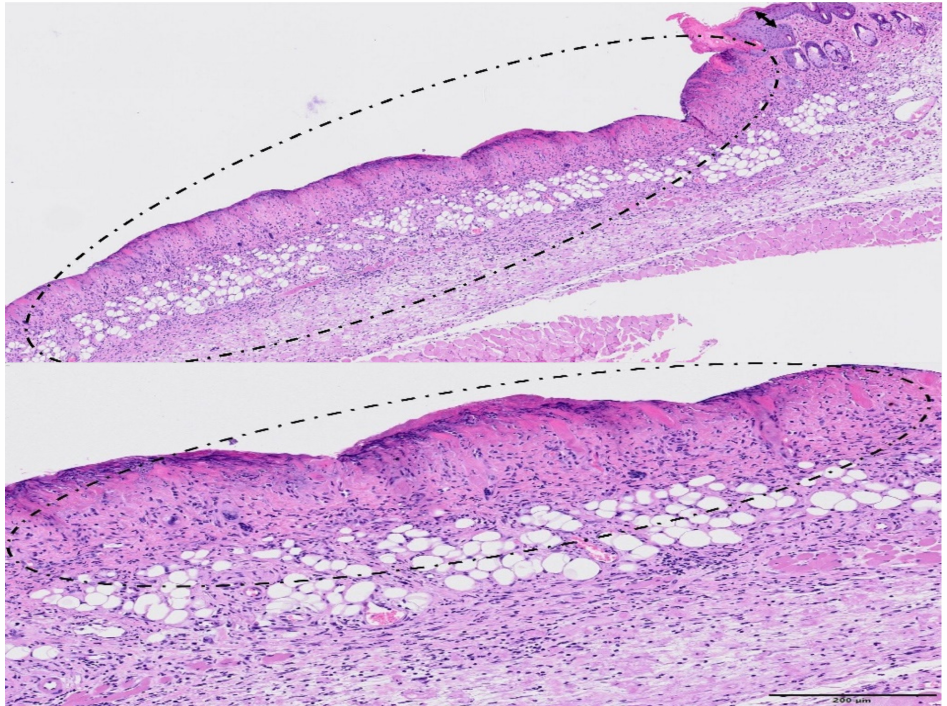
Figure 11. Broad beam irradiation. HE staining. Upper figure (bar = 500 µ m): a large area of the skin presented extensive epidermal necrosis (encircled), with abundant inflammatory infiltration and loss of annexa. There was also epidermal hyperplasia in less affected areas (double-headed arrow). Lower figure—Bar = 200 µ m: note that the loss of cellular detail of the epidermis (epidermal necrosis, encircled) at higher magnification. The subjacent dermis appears highly infiltrated by inflammatory cells.